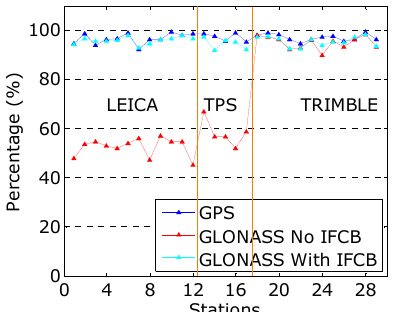
Figure 13. Fixing percentage of daily static PPP with various strategies for each rover station. Receivers with heterogeneous types are used rover sites, which are grouped according to the manufacturer. Table 3. Over-manufacturer-averaged fixing percentage of daily static PPP with various strategies.